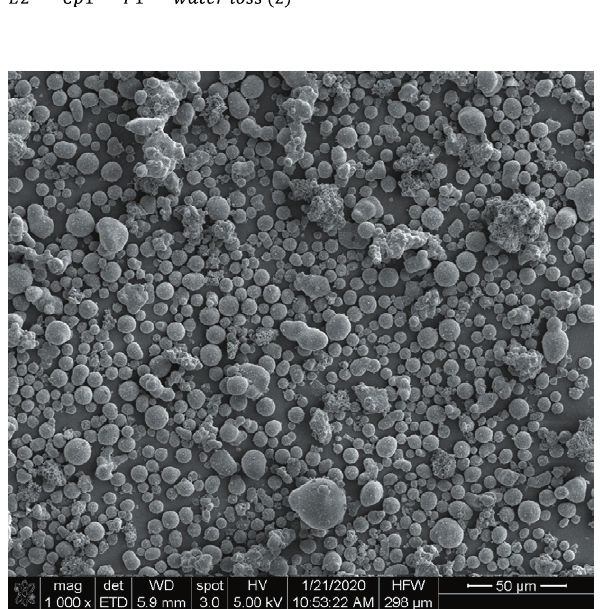
Figure 4. SEM of micro-silica spheres produced by